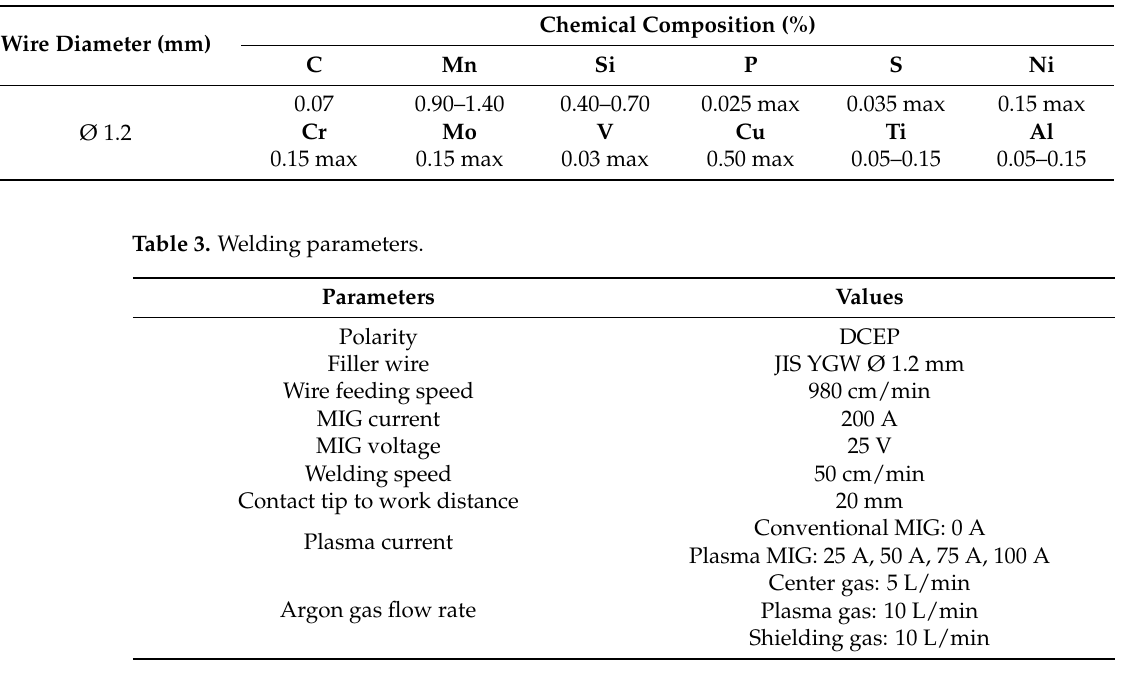
Table 2. Chemical composition of filler wire.